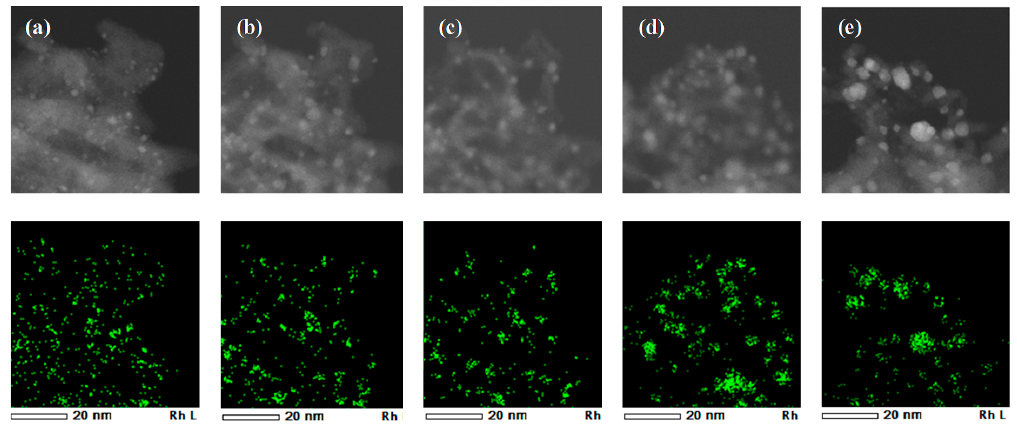
Figure 5. TEM images and EDS mapping of Rh in Rh/Al 2 O 3 under vacuum conditions at ( a ) 300 °C, ( b ) 900 °C, ( c ) 950 °C, ( d ) 1000 °C, and ( e ) 1050 °C. Table 1. Summary of the starting temperatures for the support materials and Rh particles .